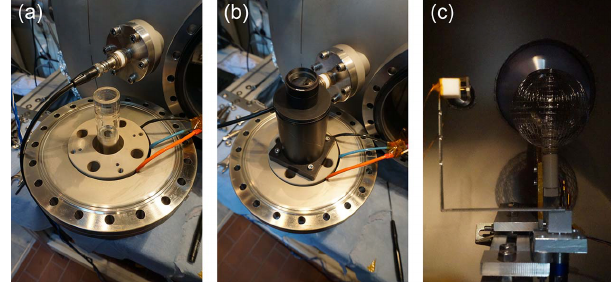
Figure 15. (a) Deuterium lamp spectrum inside its polyether ether ketone (PEEK) holder. (b) Deuterium lamp covered with baffle and filter holder. (c) Setup inside the vacuum chamber, with MSPD in the background (0 ◦ inclination) and the photodiode on its rotating arm on the left.